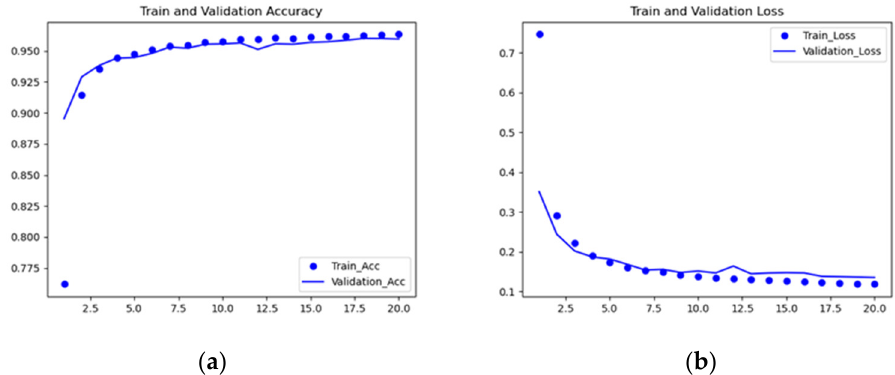
Figure 10. Verified accuracy and loss of TensorFlow model: ( a ) Training and validation accuracy; ( b ) training and validation loss.